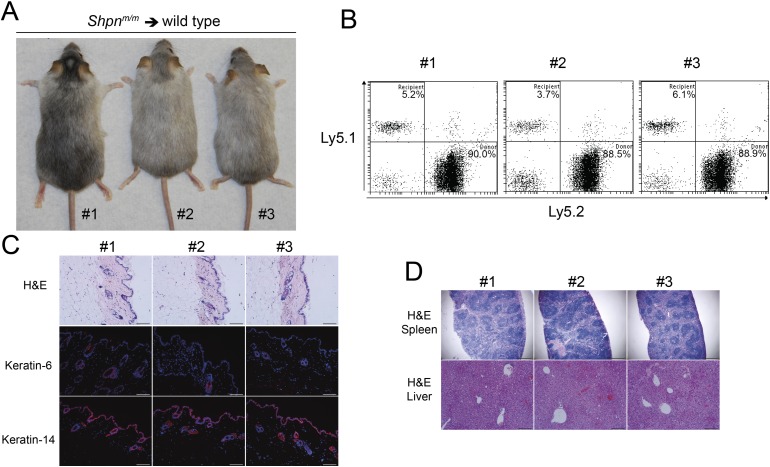
No dermatitis in wild-type mice reconstituted with Shpnm/m bone marrow after 12 months.(A) No dermatitis was observed in wild-type mice 12 months after reconstitution with Shpnm/m bone marrow. (B) Flow cytometry analysis showing percentage contribution of Ly5.1 (recipient) vs Ly5.2 (donor) white blood cells in peripheral blood 12 months after reconstitution. (C) Histological and immunofluorescence analysis of dorsal skin from mice 12 months after reconstitution. (D) Histological analysis of the spleen and liver from mice 12 months after reconstitution. Scale bars: Skin 100 µm, liver 200 µm and spleen 500 µm. H&E: hematoxylin and eosin.